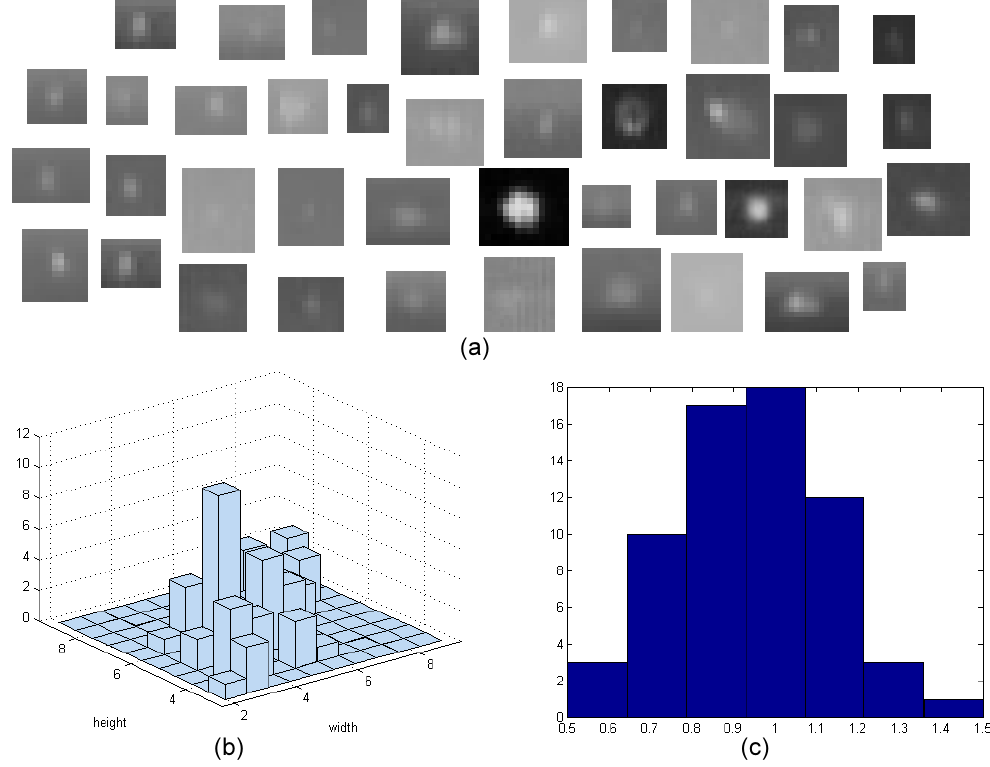
Figure 9. Observations of real infrared targets. ( a ) Examples of small infrared targets; ( b ) histograms of target size in terms of the width and height; ( c ) histograms of the aspect ratio